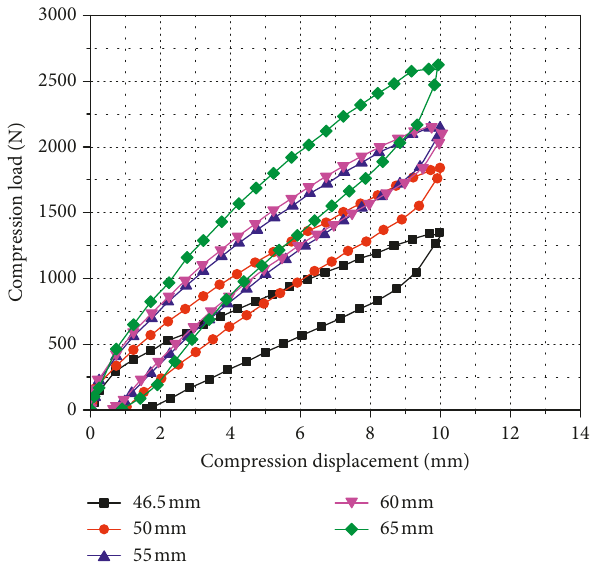
Figure 11: Hysteresis curves comparison of the GGQ-99 WRI with different bending radii.